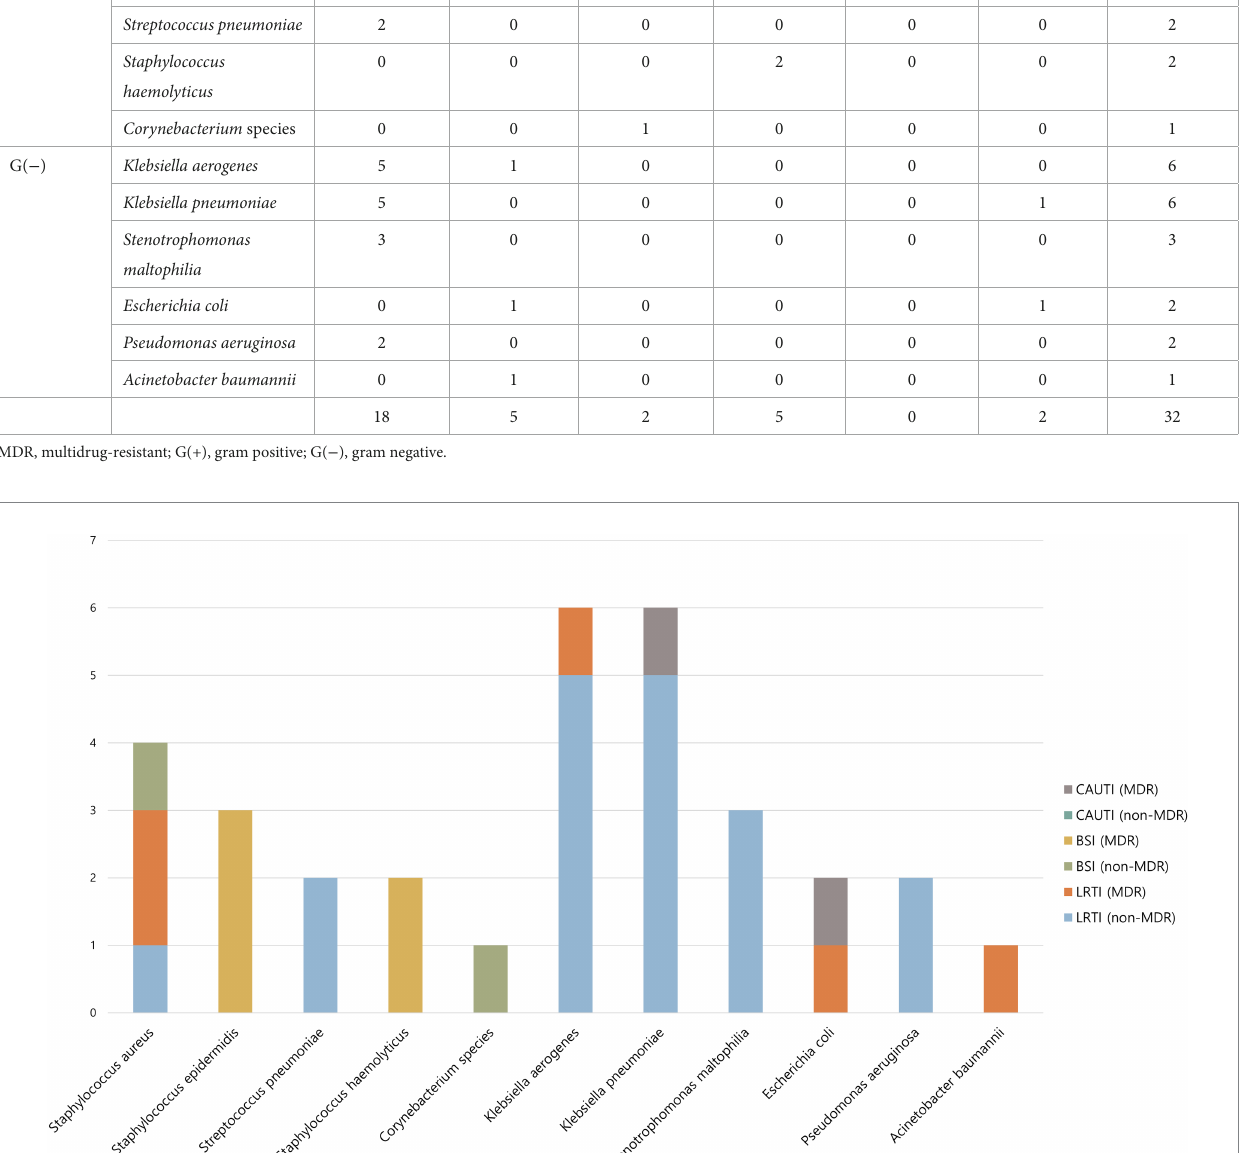
days versus 10 (IQR, 5–14) days ( p < 0.001). Additionally, the length of hospital stay after ICU admission was significantly longer in the high-risk group than in the low-risk group: 33 (IQR, 15–64) days versus 16 (IQR, 11–28) days ( p < 0.001). The ICU mortality, in-hospital mortality, and 28-day mortality rates were significantly higher in the high-risk group than in the low-risk group (Table